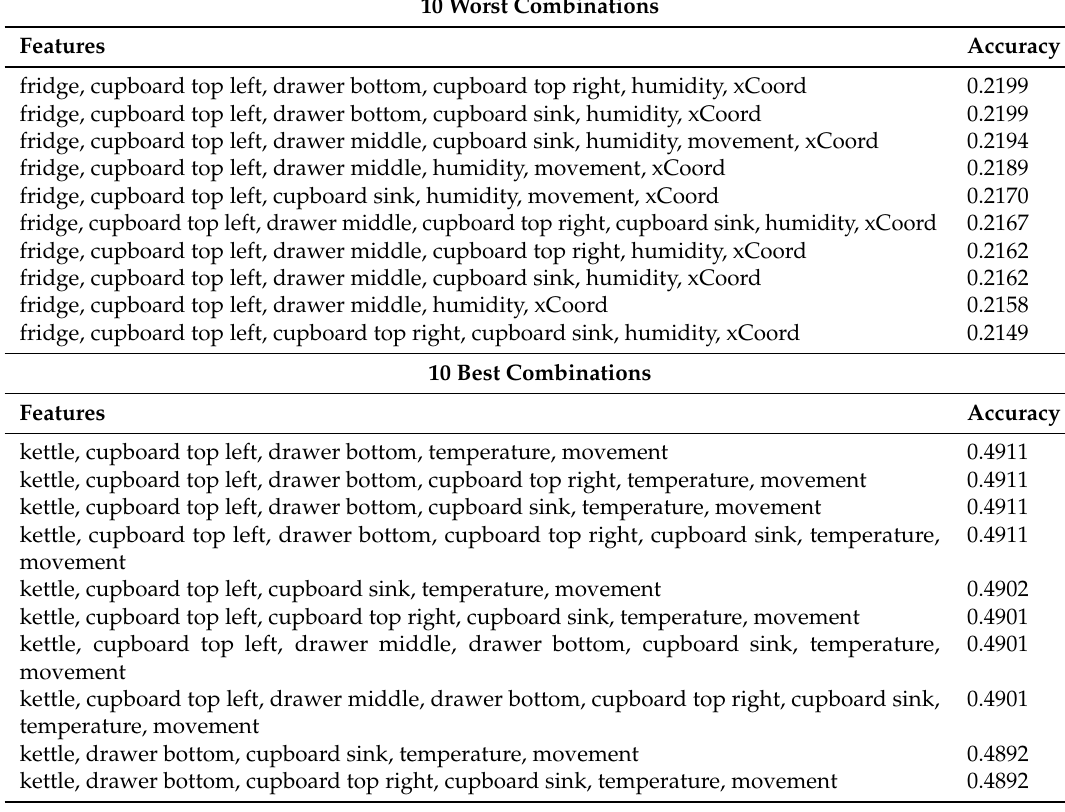
Table 8. Accuracies for the 10 worst and 10 best sensor combinations with the camera features. 10 Worst